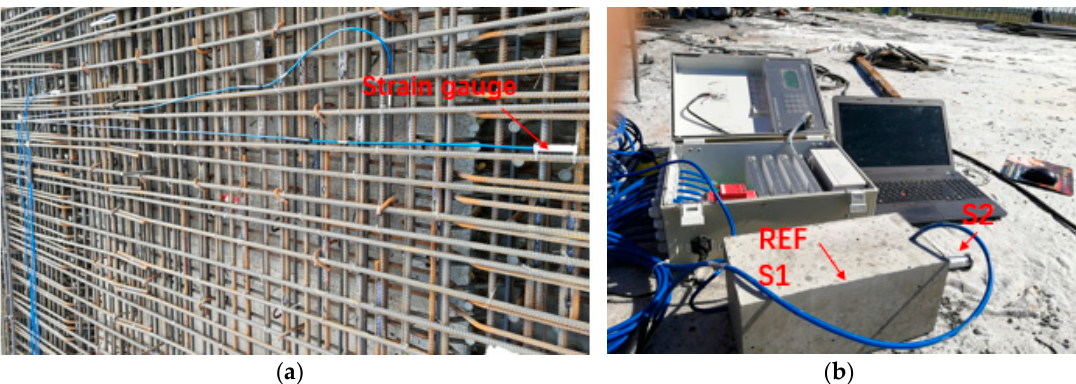
Figure 3. Field arrangement of strain gauge: ( a ) placement of strain gauge; ( b ) data acquisition. where strain gauge 1 (S1) was used to measure the temperature and deformation of Ref, and S2 was used to measure the surface temperature of the deck.